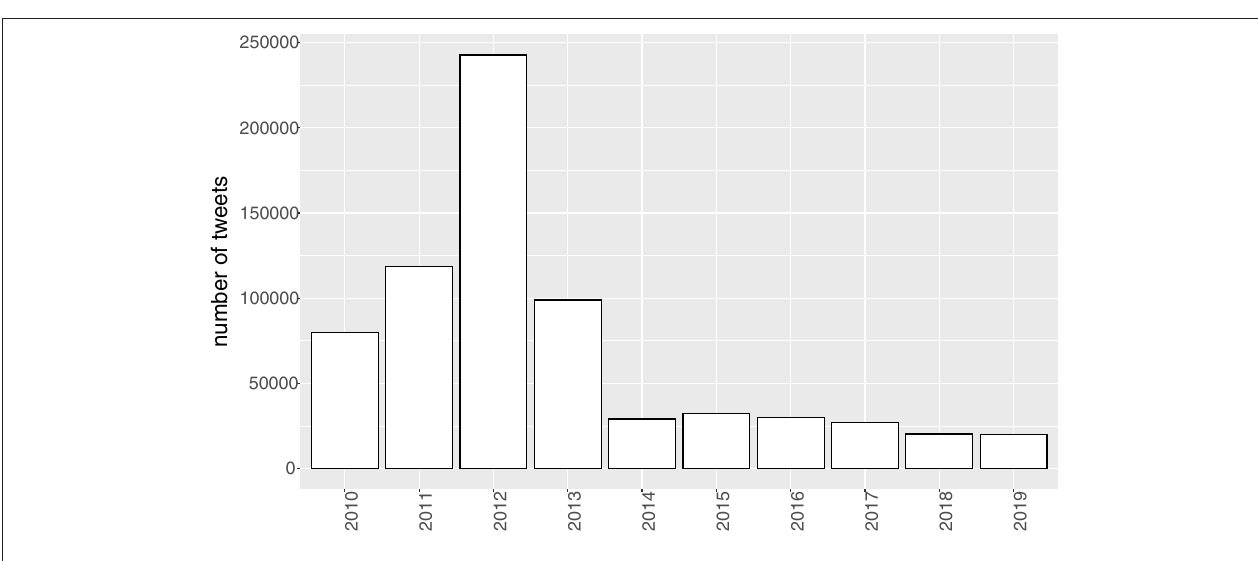
FIGURE 3 | Distribution of the number of tweets per year ( n = 698,369, N = 186).